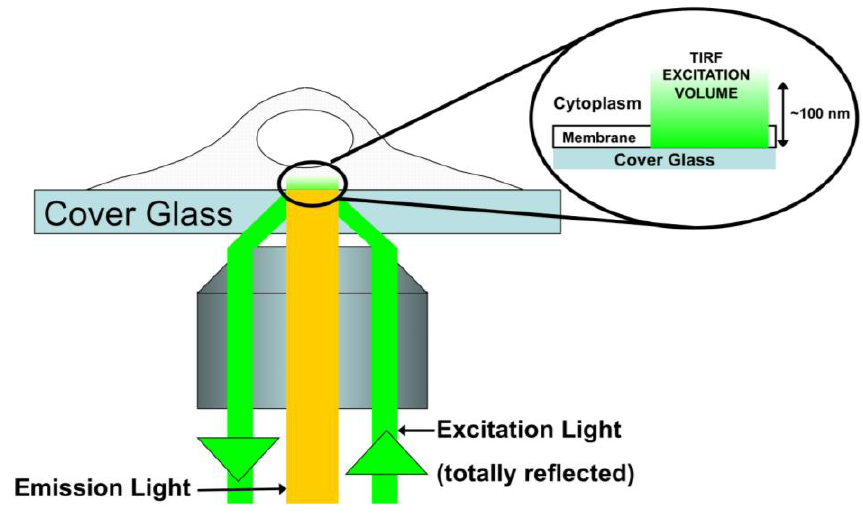
Figure 2. Total Internal Reflection Fluorescence (TIRF) microscopy. In objective-based TIRF microscopy, the excitation laser is positioned to enter at the edge of the back aperture of a high-NA objective (NA ≥ 1.45). The beam emerges from the objective at an angle, which is greater than the critical angle of the cover-slip/sample interface. Thus, the excitation beam is totally reflected back down through the objective. Despite this total reflection, an evanescent, or near-field, wave penetrates approximately 100 nm into the sample (inset). This results in a spatially confined excitation region at the cover-slip/sample interface. In cellular applications, the near-field light would only excite fluorophores at the bottom membrane, and in a small region of the cytoplasm proximal to the membrane. Therefore, this technique is ideal for probing proteins that interact with the